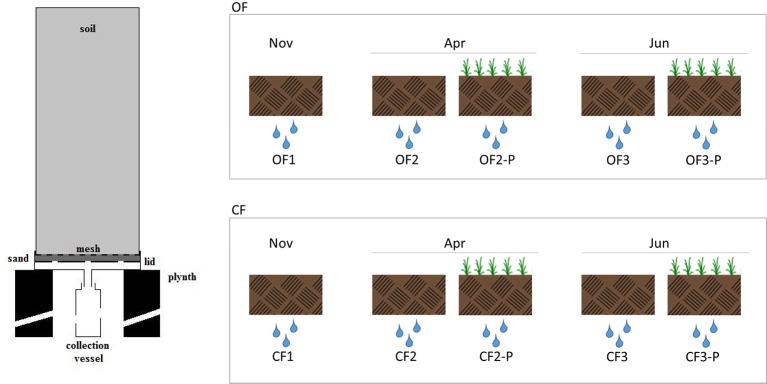
Cross-section of the soil column and leachate collection apparatus and experimental setup used in this study. The leachates were collected from organic farming soils (OF1, OF2, and OF3) or from conventional farming soils (CF1, CF2, and CF3). OF1 and CF1 were sampled in November; OF2, OF-P2, CF2, and CF-P2 were sampled in April; OF3, OF-P3, CF3, and CF-P3 were sampled in June. OF1, OF2, OF3 and CF1, CF2, CF3 refer to leachates collected from bare soil columns. OF-P2, OF-P3 and CF-P2, CF-3 refer to leachates collected from planted soil columns.